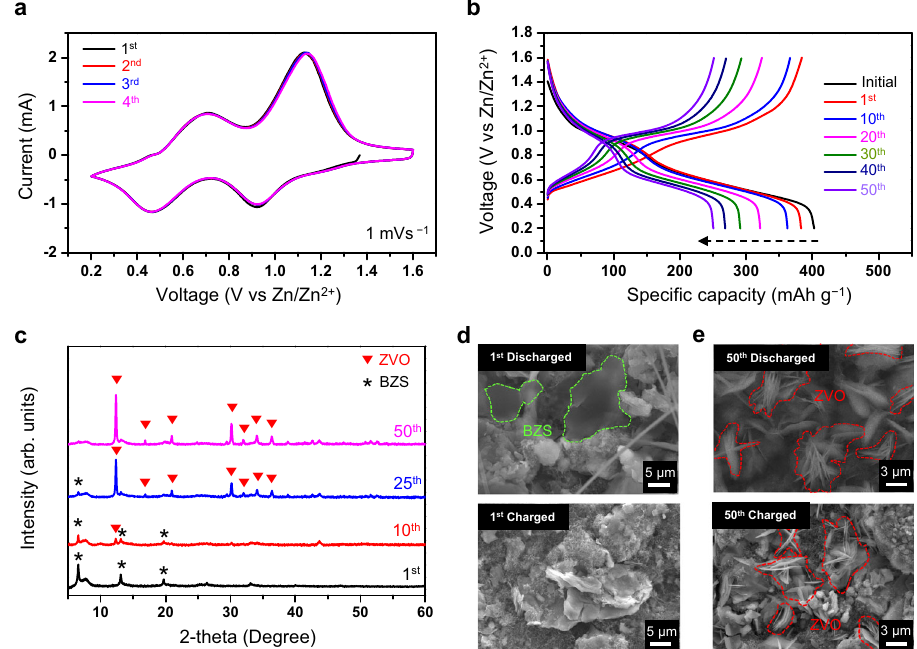
Fig. 2 Electrochemical properties of VOX electrode and its structural and morphological analyses. a Cyclic voltammetry curves of VOX electrode at different cycle numbers when scanned at a scan rate of 1 mVs − 1 . b Galvanostatic charge-discharge pro fi les of VOX electrode at different cycle numbers when cycled at 200 mA g − 1 . c Ex-situ XRD patterns of discharged VOX electrode at different cycle numbers. d , e Ex-situ SEM images of VOX electrodes at different cycling points.